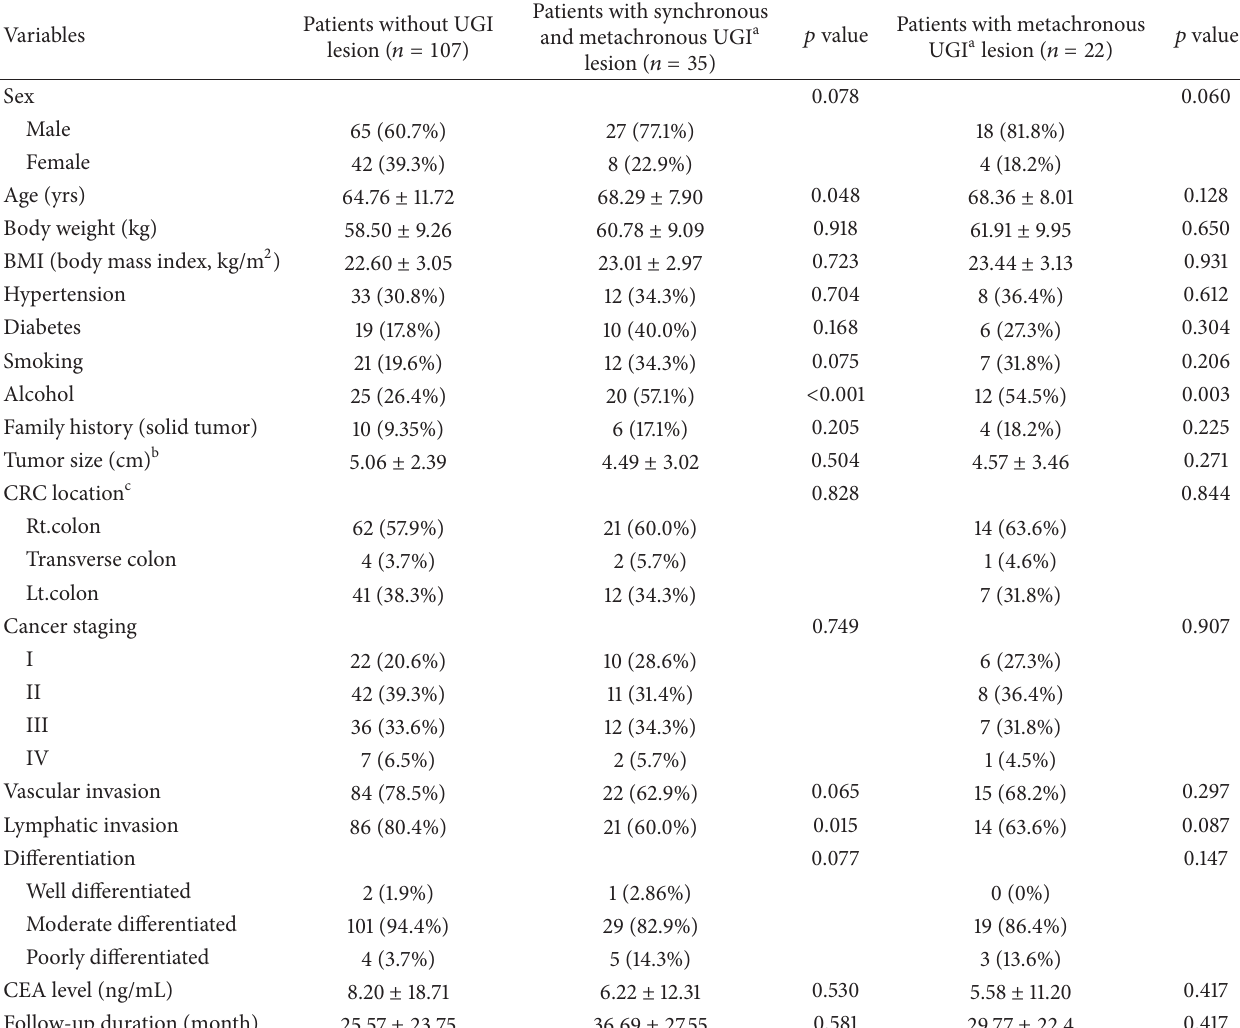
Table 1: Comparison of clinicopathologic features in the subjects with or without UGI lesion in colorectal cancer patients.